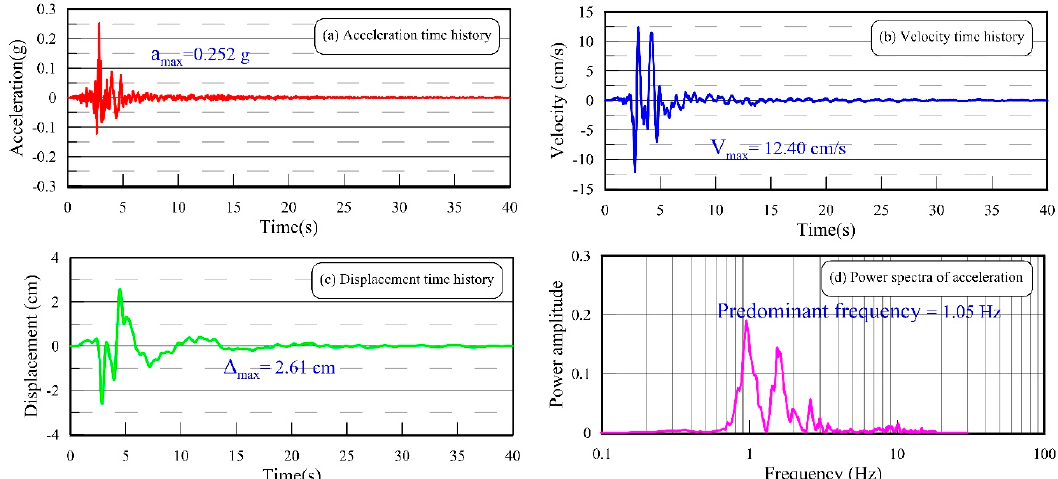
Figure 14. Information of Pohang earthquake’s ground motion at Youngil-man port extracted and